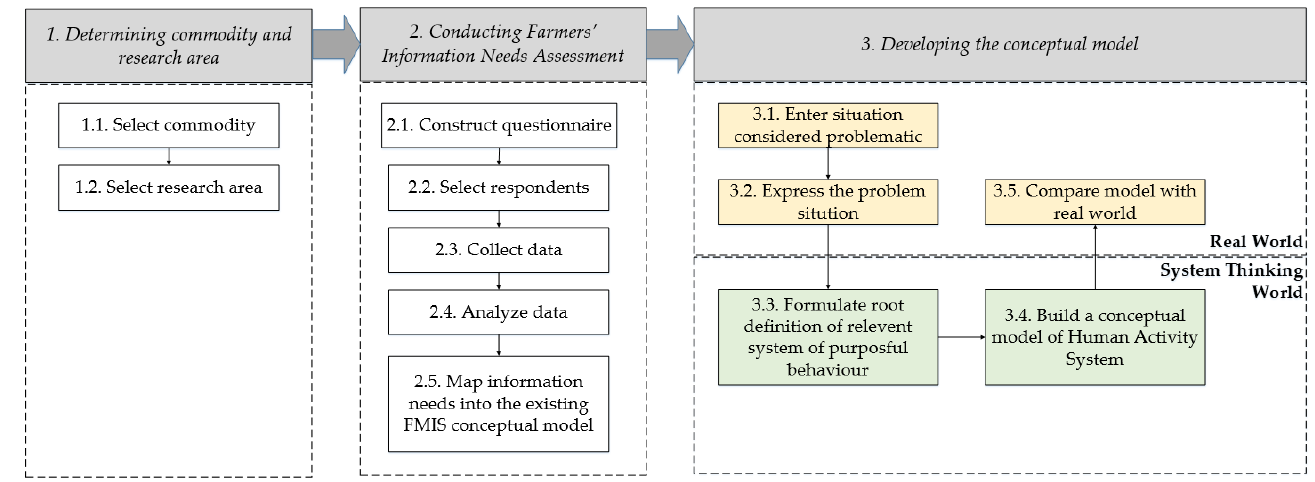
Figure 1. Research Methodology.